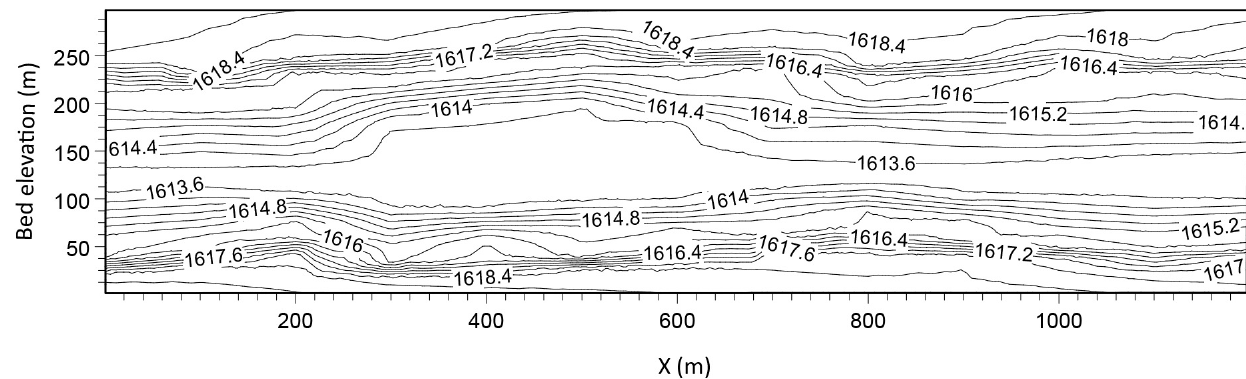
Figure 5. Bed elevation contours of the 2-D hypothetical example.